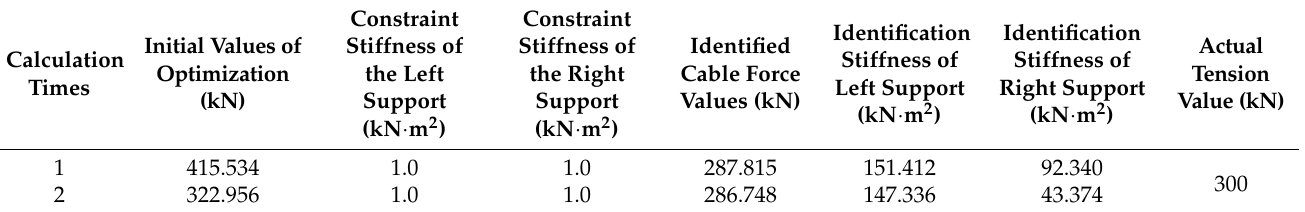
( b ) Figure 17. ( a ) Bidirectional string structure used in the experiment. ( b ) Frequency test of the bidi- rectional string structure.